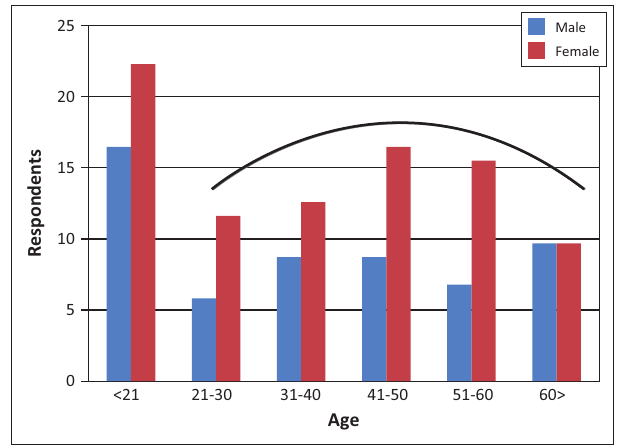
FIGURE 3: Cross-tabulation between age and gender.